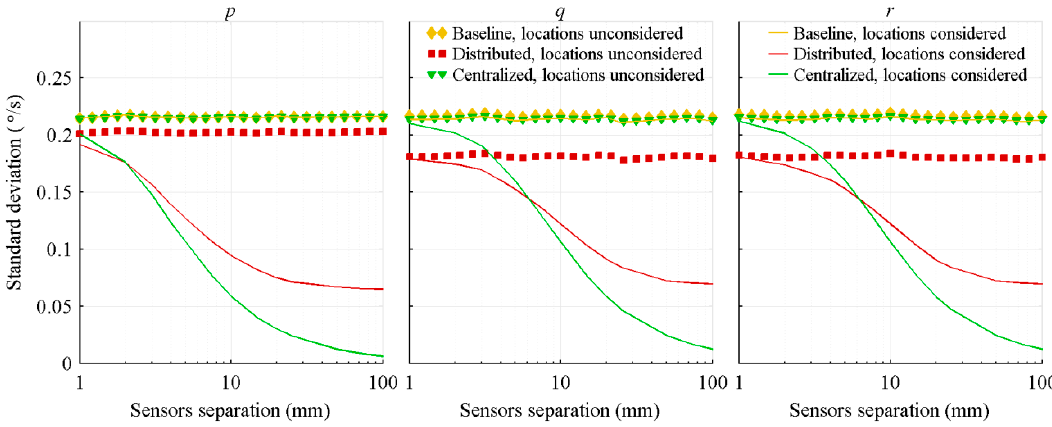
Figure 3. Standard deviation of the attitude rate estimation errors, with respect to the distance between the IMUs.